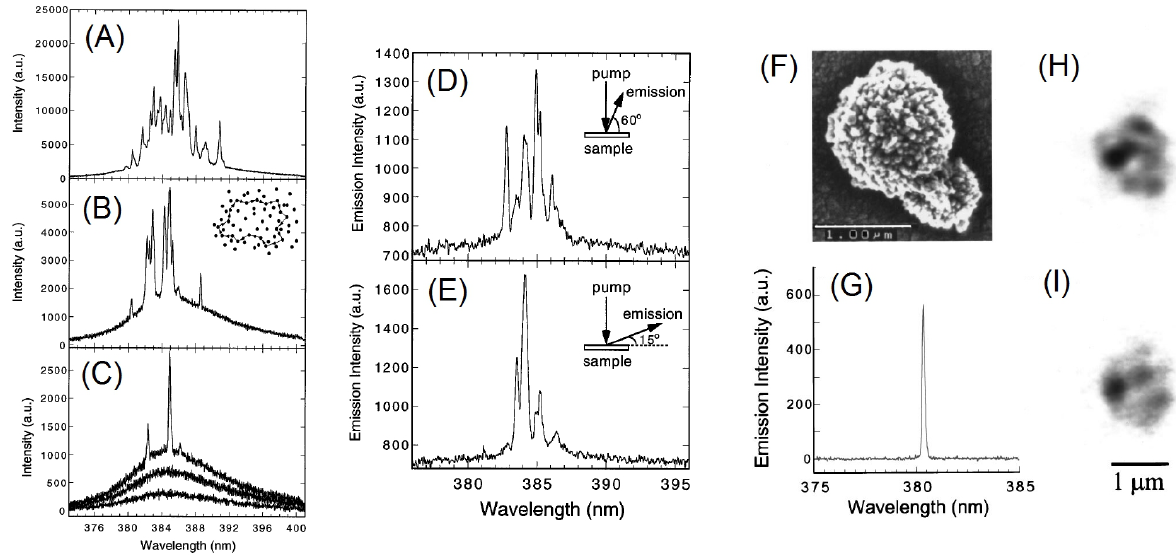
Figure 13: (A–C) Spectra of emission from ZnO powder when the excitation intensity is (from bottom to top) increased. The inset is a schematic diagram showing the formation of a closed loop path for light through recurrent scattering in the powder. (D, E) Emission spectra of laser emission into two directions: (D) 60 ∘ from the sample surface. (E) 15 ∘ from the sample surface. (F) SEM image of a second ZnO clus- ter. (G) The spectrum of emission from this cluster above the lasing threshold. The incident pump pulse energy is 0.27 nJ. (H, I) The spatial distribution of emission intensity in the cluster at the same pump power. Reproduced with permission from Ref. [119] (A–E) and [139] (F–I). SEM: secondary electron microscope.